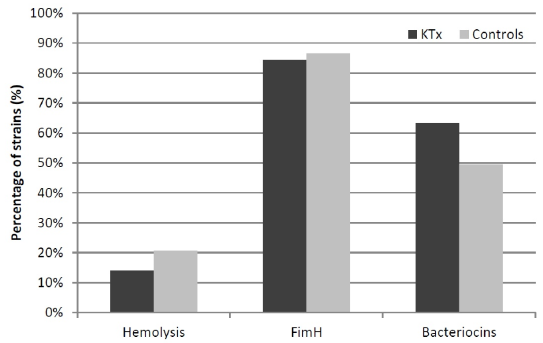
Figure 3. Phenotypic characteristics of the KTx and control UPEC isolates. The percentage of strains phenotypically tested positive for the expression of α -hemolysin, type 1 fimbriae and bacteriocins killing E.coli DH5α has been compared between the KTx and control groups.